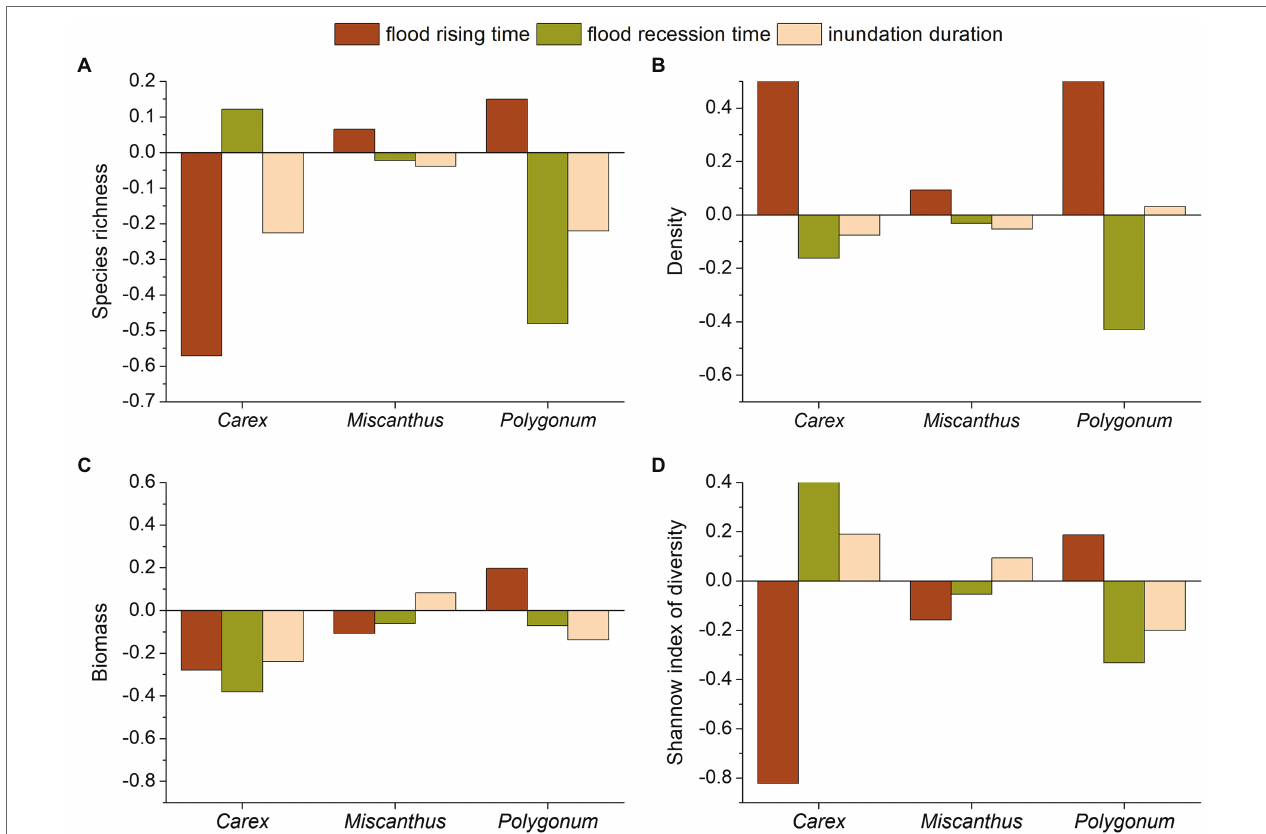
FIGURE 6 | Marginal effects of each hydrological variable (including flood rising time, flood recession time, and inundation duration) on the community traits (species richness (A) , density (B) , biomass (C) , and Shannon index of diversity (D) of the three plant communities) of three macrophytes in Dongting Lake wetlands.